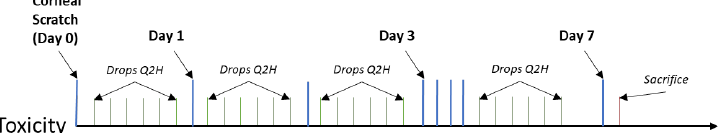
Figure 1. Timescale for cytotoxity study: Mice were given an abrasion on Day 0. Drops of IgG or MEDI3902 were administered Q2H (every two hours) for seven days. Mice were scored and sacrificed on Day 7 after abrasion.